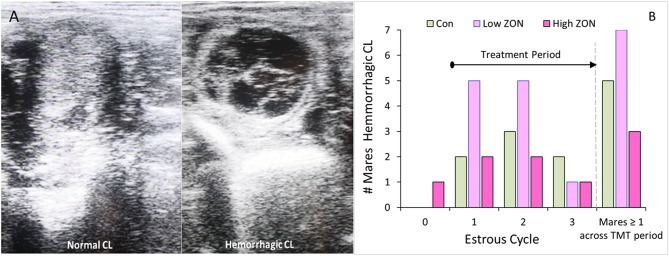
Corpus luteum development: (A) Ultrasound comparison of Normal and Hemorrhagic CL; (B) Incidence of hemorrhagic corpora lutea (HCL) by cycle, such that time on ZON treatment increases with cycle number. The last set of bars: number of mares by treatment having at least one HCL over entire study period. ZON treatments are: Control (n = 6) 0 mg/da, Low (n = 7) 2 mg/da, High (n = 7) 8 mg/da.